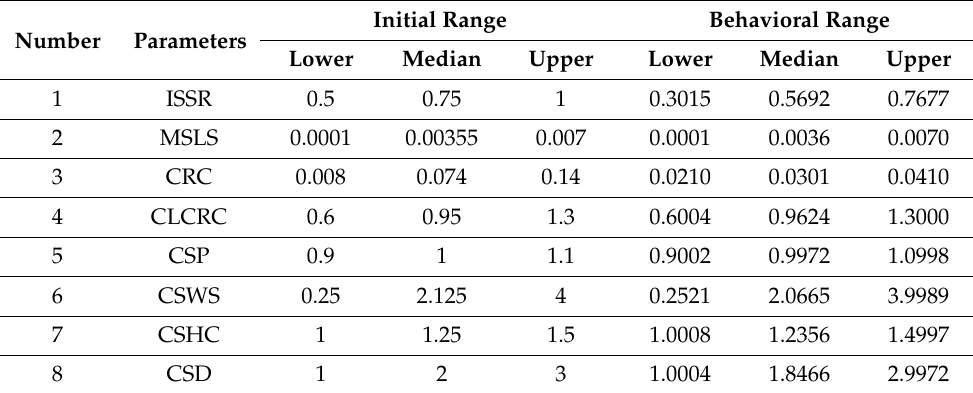
Table 8. L 2 − based parameter range of behavioral